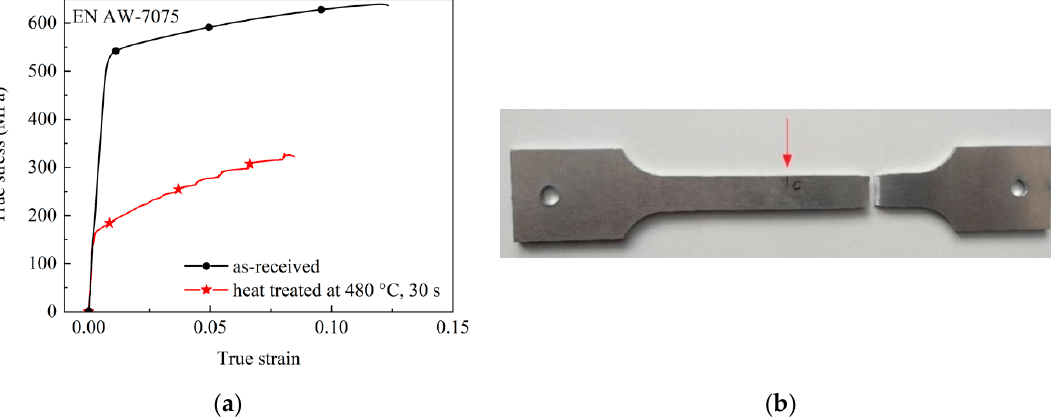
Figure 7. ( a ) Stress-strain curves of EN AW-7075 before and after SHT. ( b ) Specimen of a tensile test after SHT which, as in all such tests, broke outside the gauge length; the red arrow points at the center with reference to the undeformed specimen.